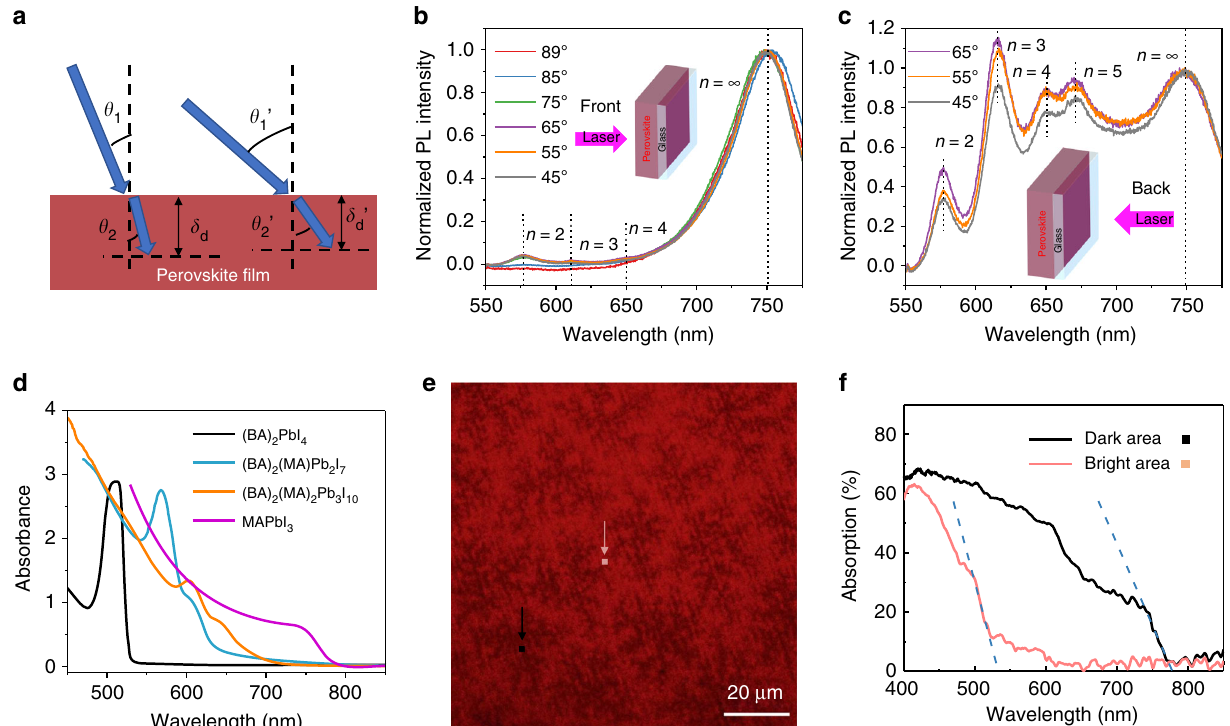
Fig. 3 Vertical and lateral phase segregation investigation. a Schematic of incident-angle dependent photoluminescence (PL) setup. b The incident-angle- dependent PL spectra of the layered perovskite fi lms illuminated from the front sides (as illustrated in the inset) of the fi lms. c The incident-angle- dependent PL spectra of the layered perovskite fi lms illuminated from the back sides (as illustrated in the inset) of the fi lms. d Absorption spectra of three- dimensional (3D) MAPbI 3 thin fi lms and the layered (BA) 2 (MA) n -1 Pb n I 3 n + 1 perovskite thin fi lms ( n = 1 to 3). e Optical mapping of the layered perovskite (BA) 2 MA 3 Pb 4 I 13 fi lms using an optical microscope in transmission mode. Typical bright and dark area are labeled with pink and black squares, respectively. f Absorption spectra measured in the bright and dark area labeled in e . The size of the measured area is 0.6 × 0.6 µ m 2 , smaller than the labeled